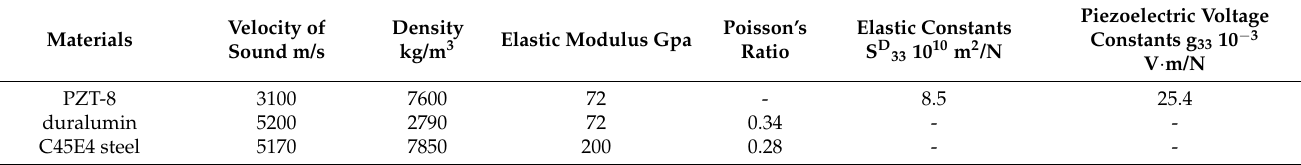
Table 2. Parameters of each component material of the